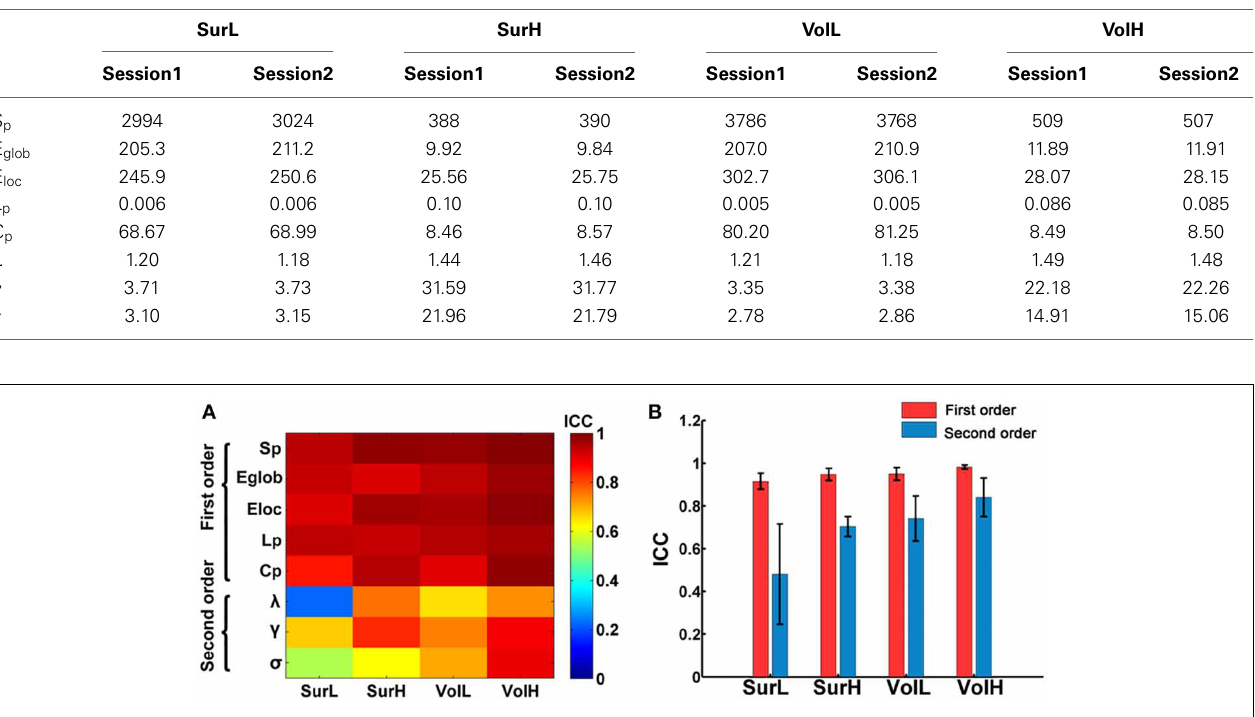
of the effects of network construction procedures on the reliability of first order and second order graph metrics. The bars and errorbars represent the mean values and standard errors, respectively, of the ICC values of first order and second order network